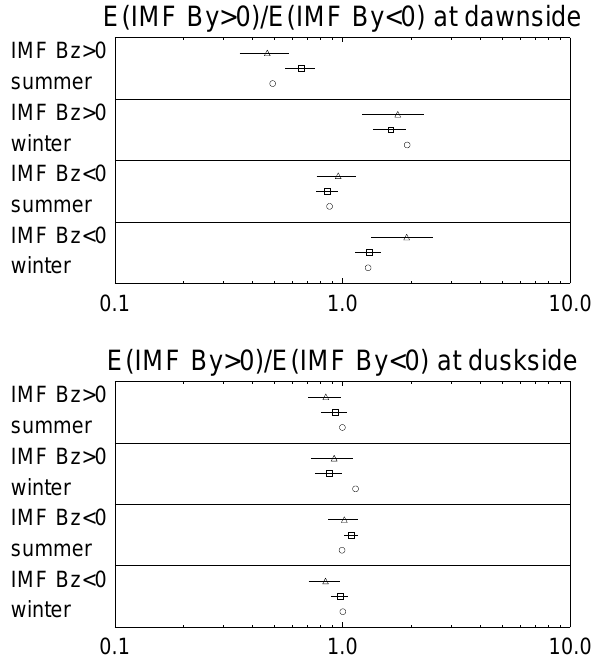
Fig. 6. Ratio of the electric fields for IMF B Y > 0 to those for IMF B Y < 0 sorted by 1) dawnside and duskside, 2) polarity of IMF B Z , and 3) summer and winter. See text for the